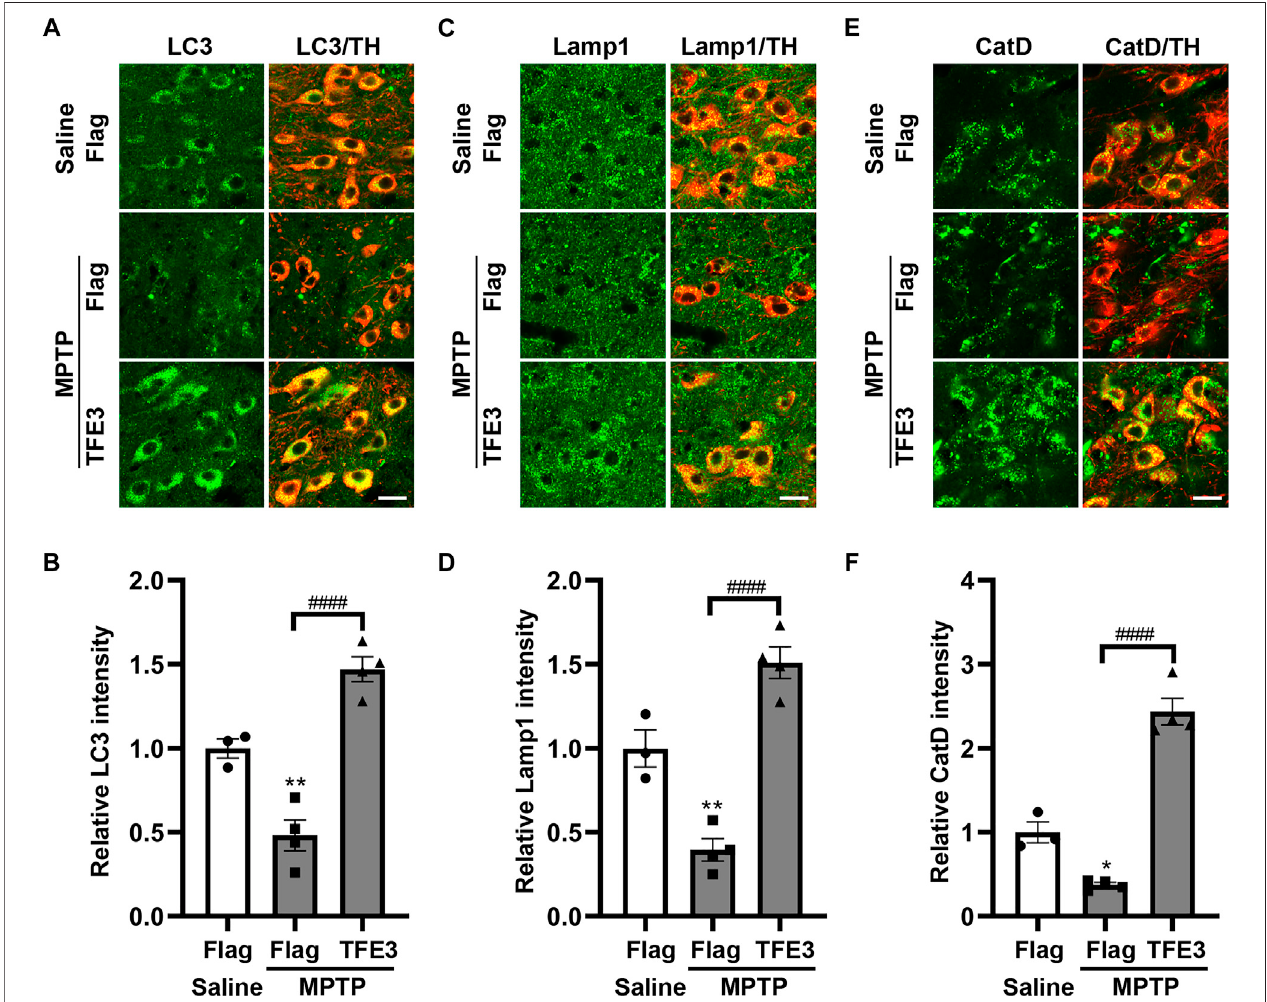
FIGURE5| TFE3overexpressionrescuestheautophagydefectsofdopaminergicneuronsinMPTP-treatedmice. (A,CandE) DetectionofLC3(green,A),Lamp1 (green,C)andCatD(green,E)indopaminergicneurons(red)oftheSNfromSaline-andMPTP-injectedmiceoverexpressingFlagorTFE3.Scalebars:20 μ m.